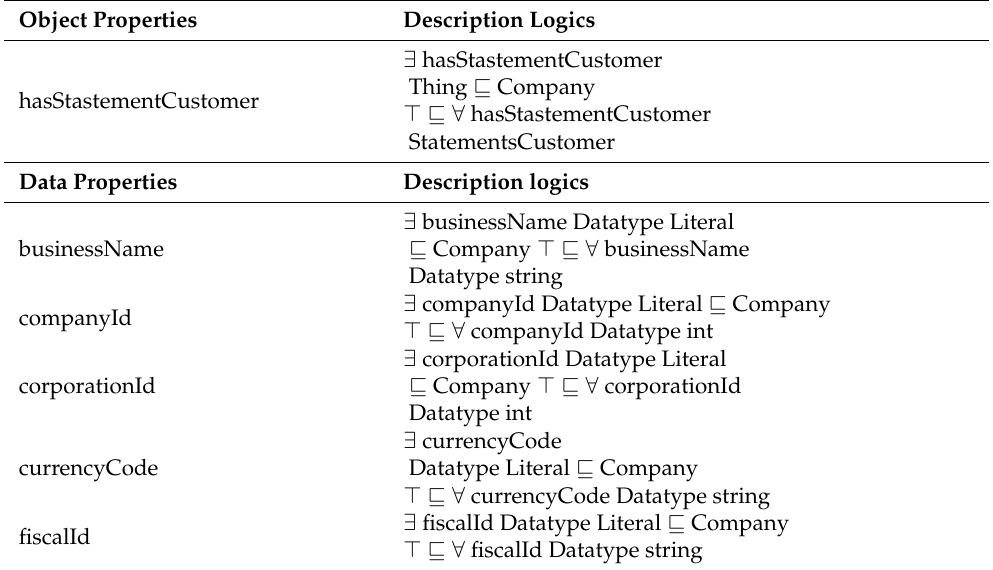
Table 2. Data and object properties of class